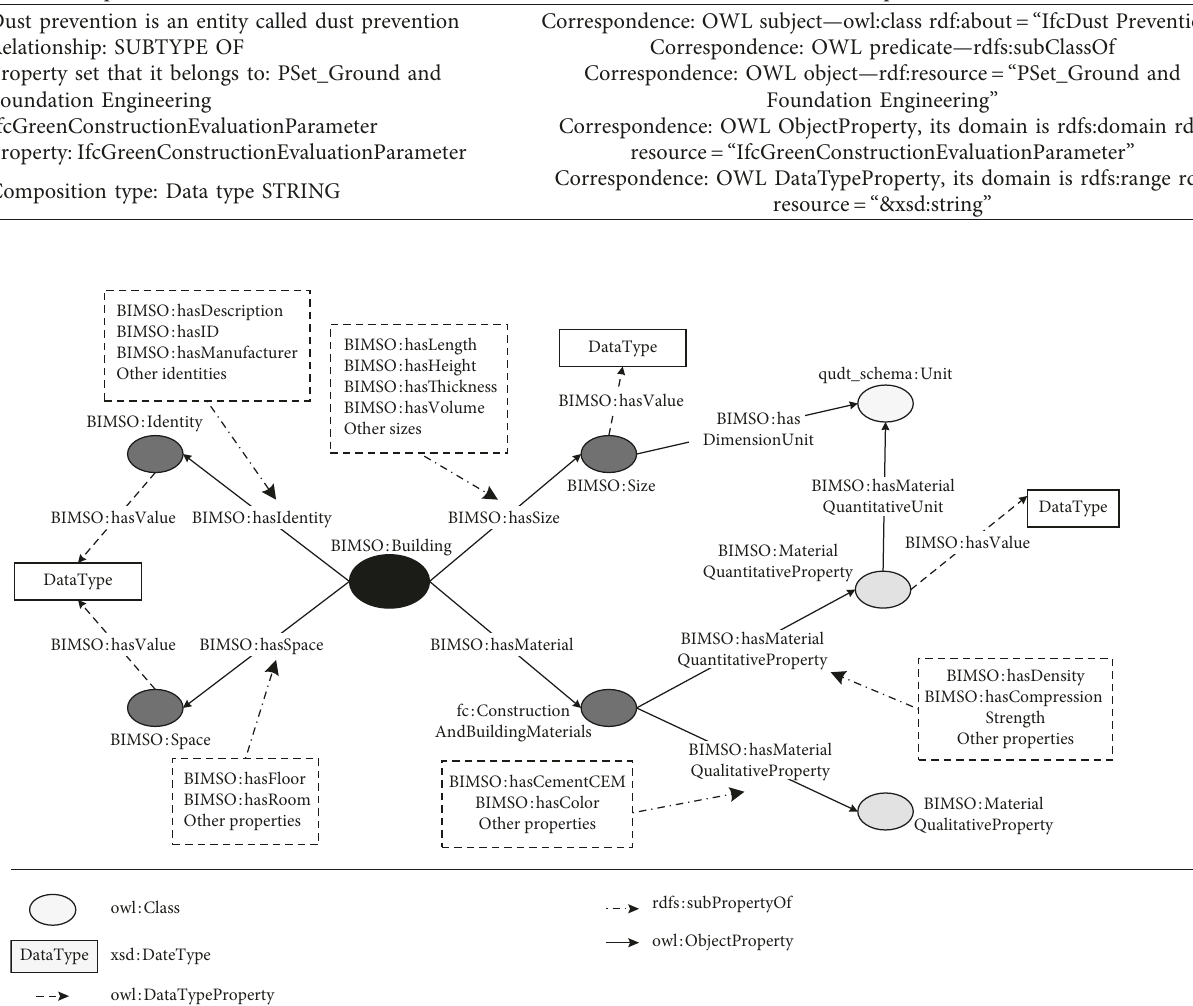
Figure 6: Concept of BIM ontology.